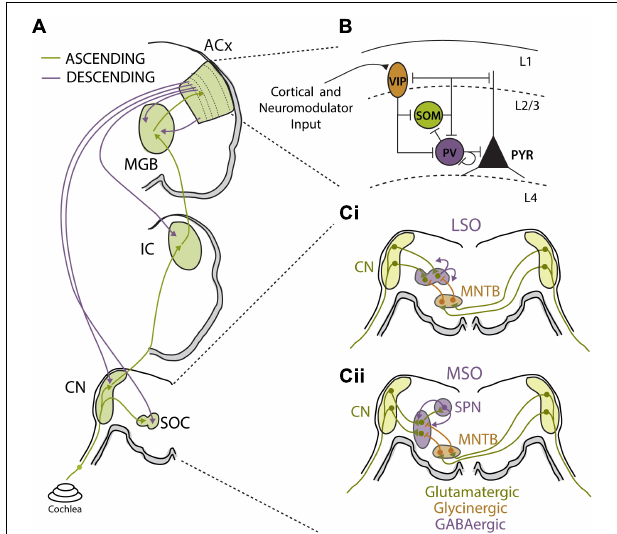
FIGURE 3 | Auditory circuit mechanisms for bottom-up and top-down adaptations. (A) Schematics of major auditory ascending (green) and descending (purple) pathways and associated auditory processing nuclei from the cochlea to auditory cortex (ACx). Major sound processing nuclei are highlighted in green, including the cochlear nucleus (CN), superior olive complex (SOC), inferior colliculus (IC), medial geniculate body (MGB), and ACx. Ascending pathways primarily terminate in layer 4 of ACx while corticofugal projections originate in layer 5b and layer 6 and can terminate at every level of the ascending pathway. (B) Summary figure showing known inhibitory relationships between parvalbumin (PV), somatostatin (SST), and vasoactive intestinal peptide (VIP)-positive neurons and their combined influences on excitatory cell populations. In this largely accepted model, locomotion, or top-down input, preferentially activates VIP cells, reducing SST cell output and releasing PV and excitatory cells from inhibition. PV activity can reduce background noise that improves signal-to-noise encoding of sensory stimuli by excitatory cell populations. Cortical layers are shown and separated by dashed lines. Figure was adapted from Pakan et al. (2016). (Ci,ii) Schematics of sound localization circuits of auditory brainstem used for processing interaural level (Ci) and timing (Cii) differences. (Ci) Principal neurons of lateral superior olive (LSO) receive excitatory glutamatergic inputs (green) from ipsilateral CN and glycinergic inhibition (orange) from ipsilateral medial nucleus for the trapezoid body (MNTB). MNTB receives excitatory input from contralateral CN. The interaction of ipsilateral excitation and contralaterally driven inhibition drives LSO firing in manner that can be used to calculate interaural level differences (ILD). LSO principal neurons release GABA (purple) in activity-dependent manner to asymmetrically modulate function of both glutamatergic and glycinergic inputs via activation of pre-synaptic GABA B receptors. (Cii) Principal neurons of the medial superior olive (MSO) receive excitatory glutamatergic inputs (green) from ipsilateral CN and contralaterally driven glycinergic inhibition (orange) from ipsilateral MNTB. MSO neurons also receive ipsilaterally driven inhibition from lateral nucleus of the trapezoid body (not shown). MSO neurons send excitatory projections to superior olivary nuclei (SPN), which in turn send feedback GABAergic projections (purple) to the